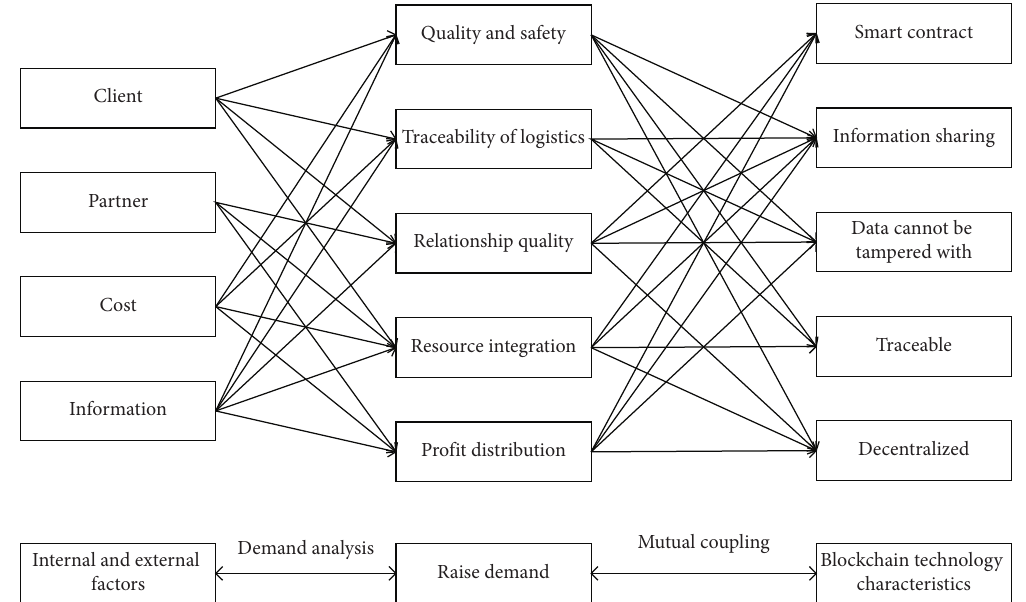
Figure 1: Blockchain technology characteristics and fresh food e-commerce supply chain performance optimization demand coupling.